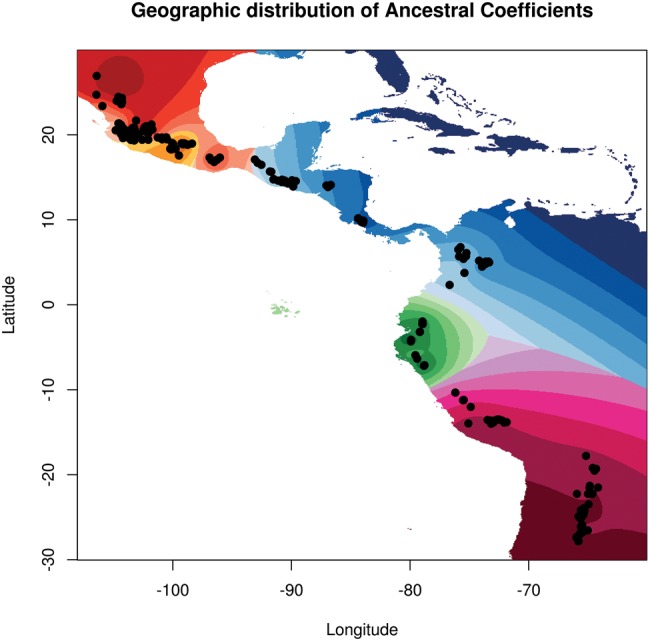
Spatial interpolation of population ancestry coefficients across the geographic distribution of the genotypes analyzed. Populations are colored as in figure 2.